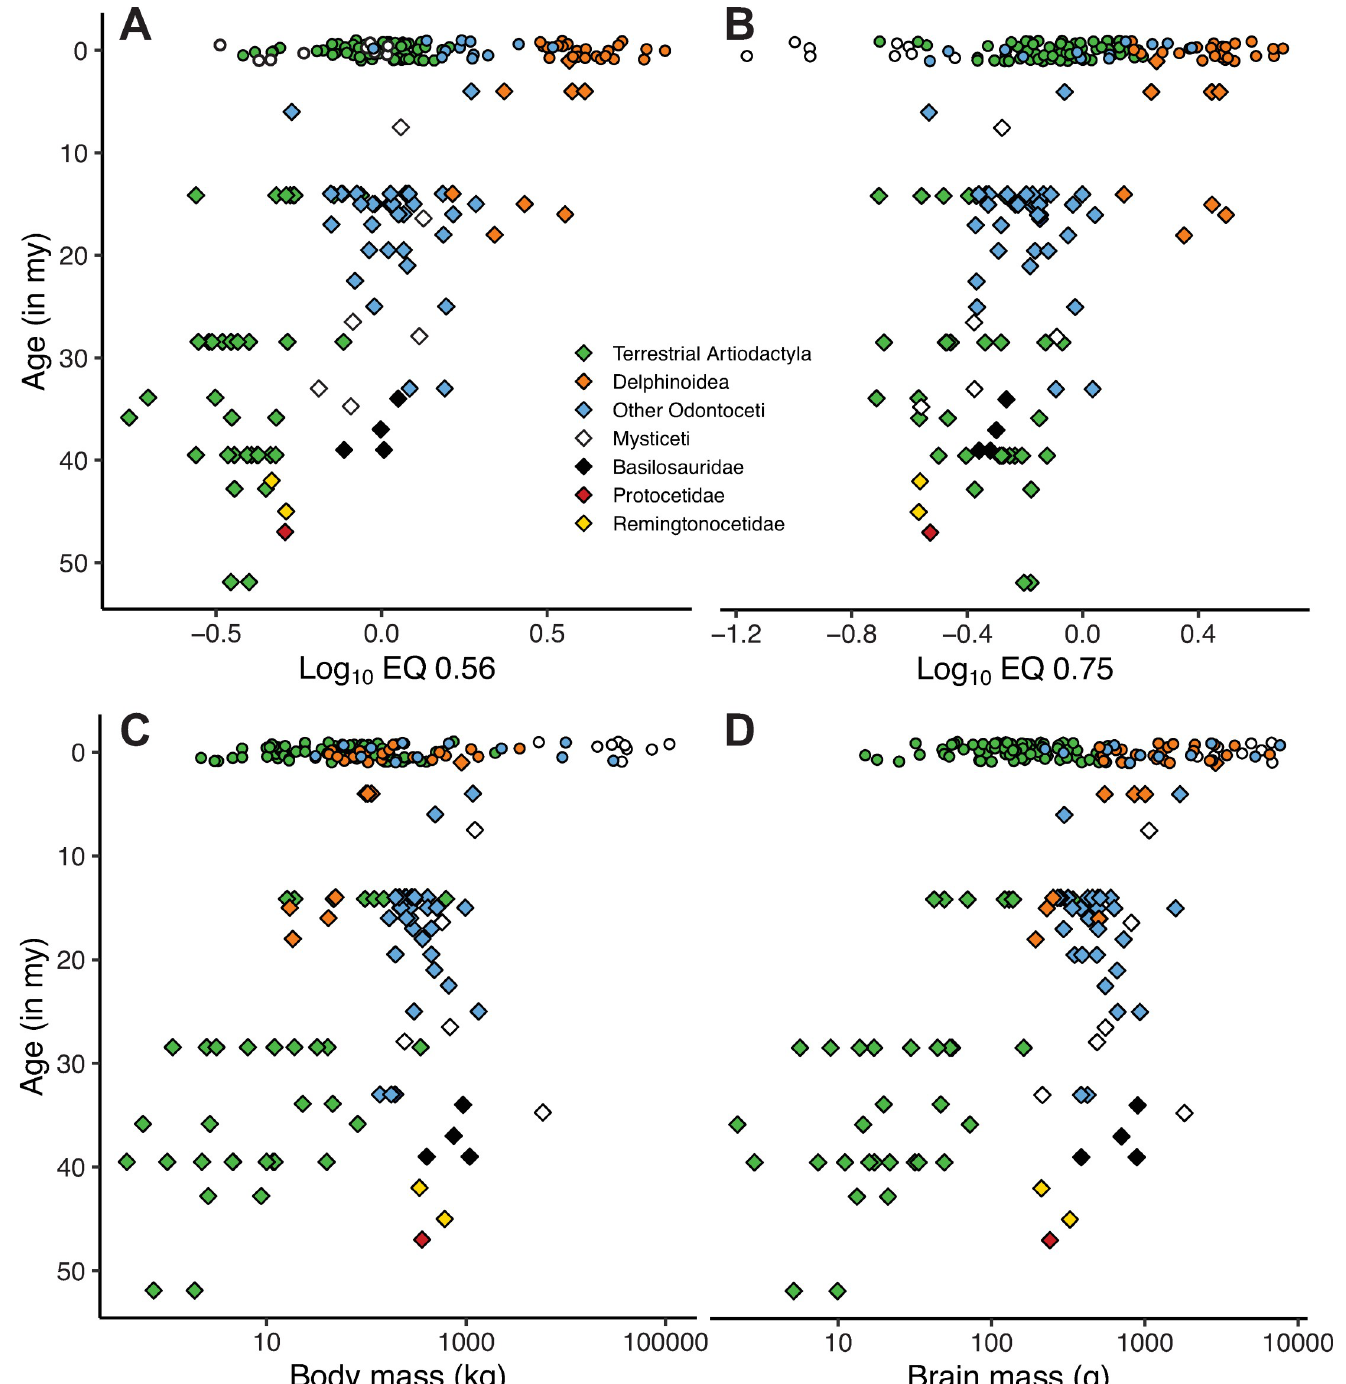
Fig 6. EQ .56 , EQ .75 , and body and brain mass through time for cetaceans and terrestrial artiodactyls. Age in millions of years before present; extant specimens (circles) are randomly dispersed around the zero datum to increase visibility.